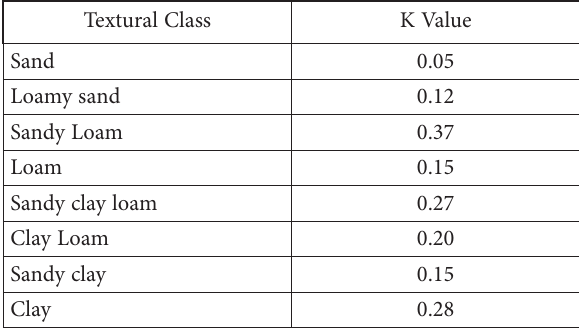
Table 1. Soil Erodability Factor K fact (source: Wischmeier & Smith, 1978)